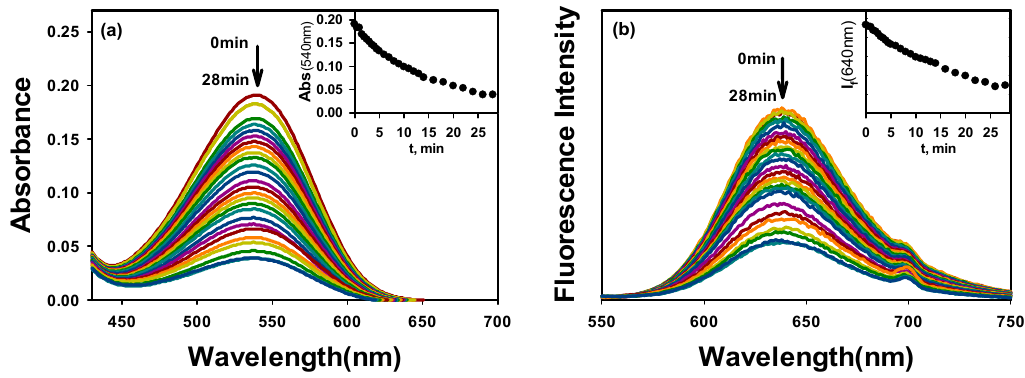
Figure 2. ( a ) Absorption and ( b ) fluorescence spectral changes by reverse reaction from MC-IQ (formed after irradiation of SP-IQ with 350 nm light for 7 min) to SP-IQ over time (0–28 min, Different color lines represent different irradiation times.) under room illumination. Inset: Plots of ( a ) absorbance at 540 nm and ( b ) fluorescence intensity at 640 nm vs . room illumination time.